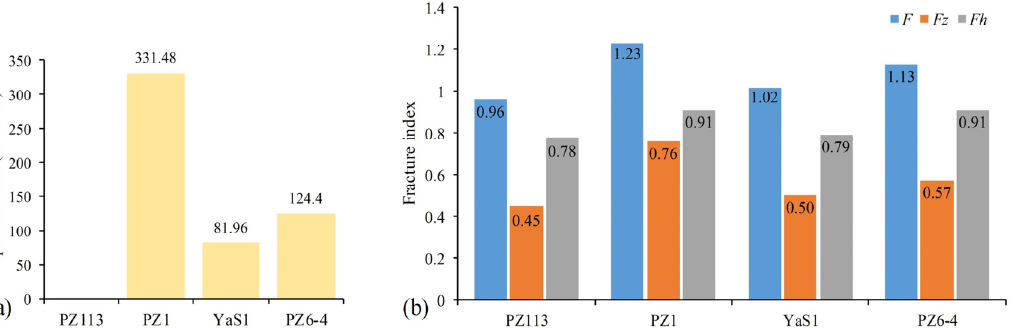
Figure 12. ( a ) Image-logging of well PZ1, ( b ) statistical results of fracture dip angle, and ( c ) rose diagram of fracture strike in the T 2 l 4 Formation. Figure 13. ( a ) Tested open flow rate of the four wells, and ( b ) fracture index of four wells in the study area.